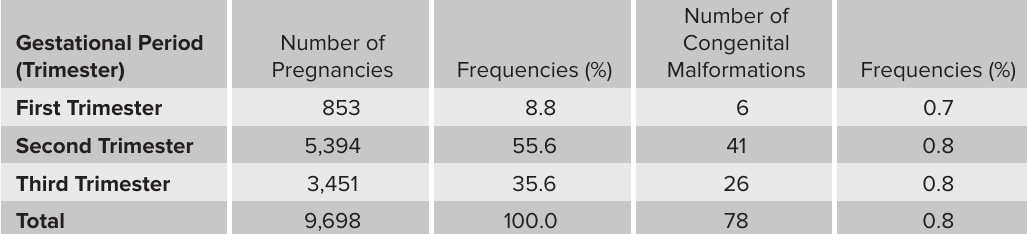
Table 1: Frequencies of Major Congenital Malformations During